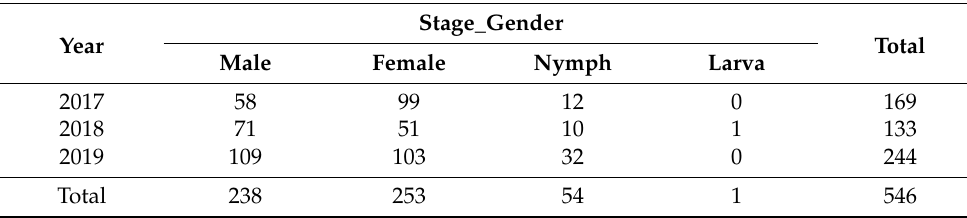
Table 2. Collection data of Ixodes ricinus ticks by years and